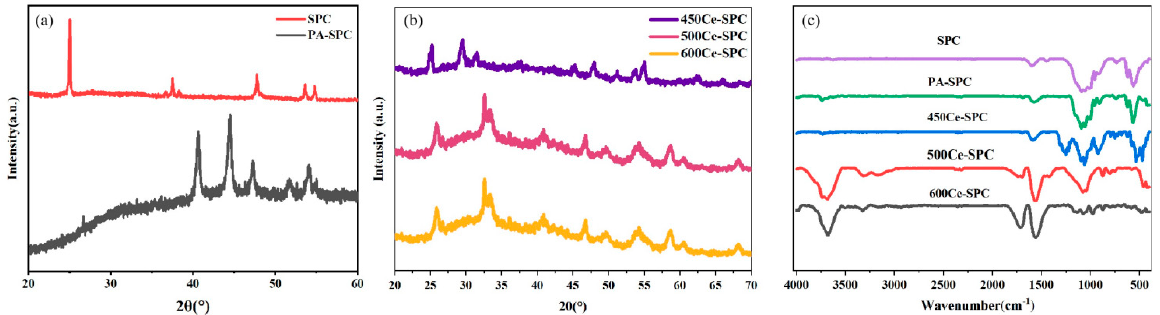
Figure 1. XRD patterns of pure SPC and PA-SPC composite catalysts ( a ), XRD patterns of 450 Ce − SPC/500 Ce − SPC and 600 Ce − SPC composite catalysts ( b ), FT − IR image of the different SPC samples ( c